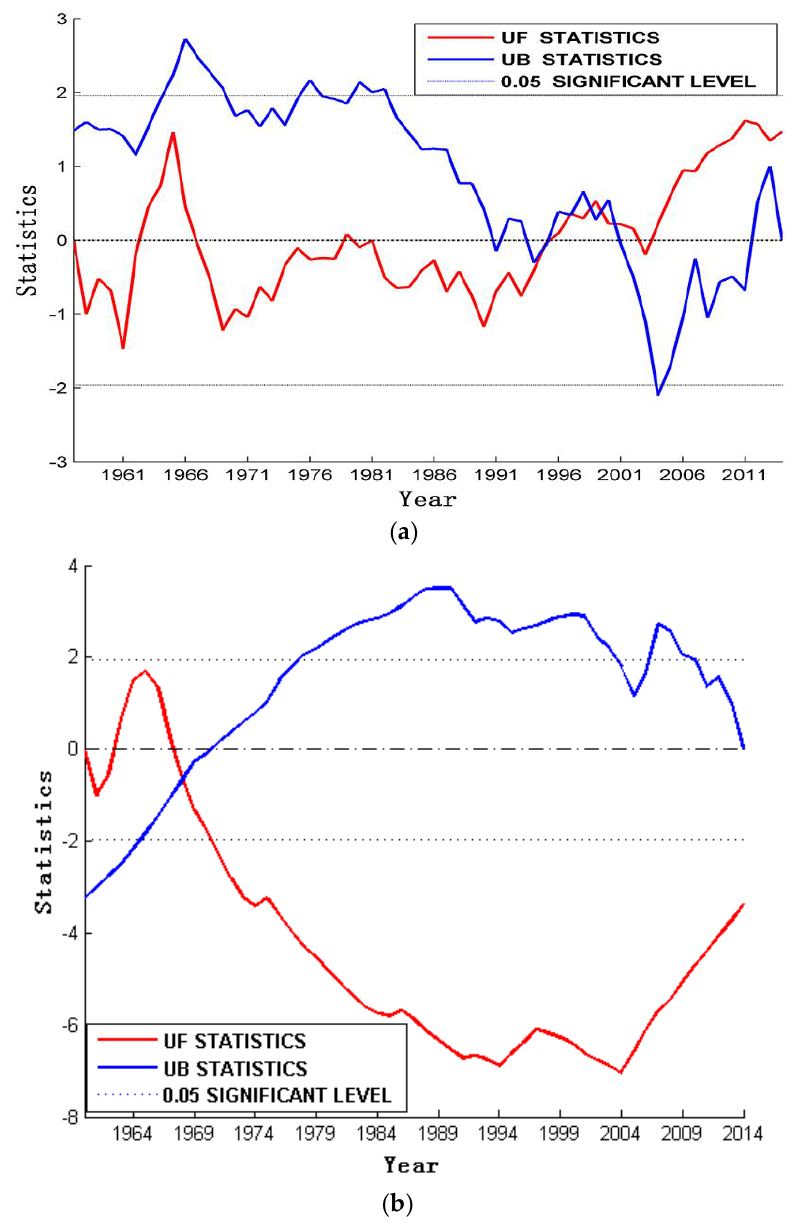
Figure 9. M-K mutation test chart. ( a ) for atmospheric precipitation; ( b ) for spring water level